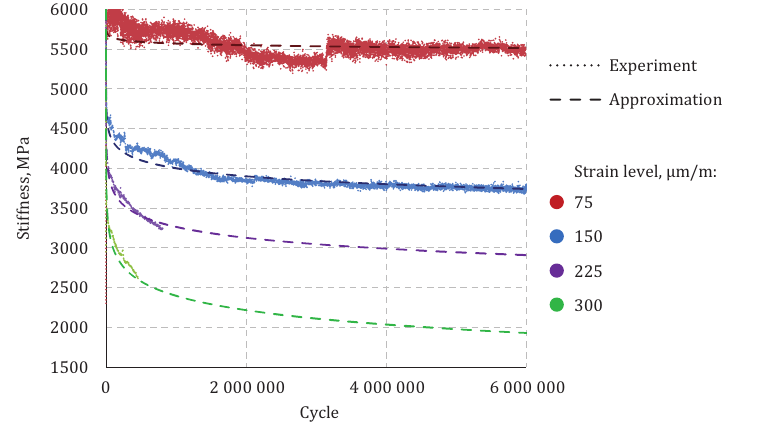
Figure 1. Fatigue curves of AC11